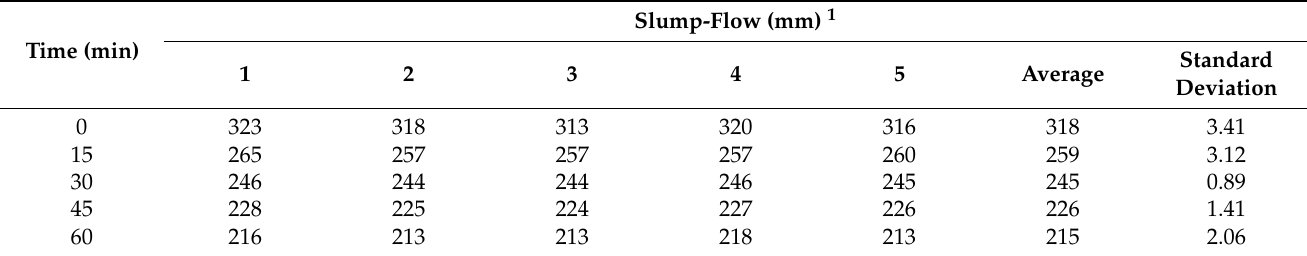
Table 4. Slump-flow test results.